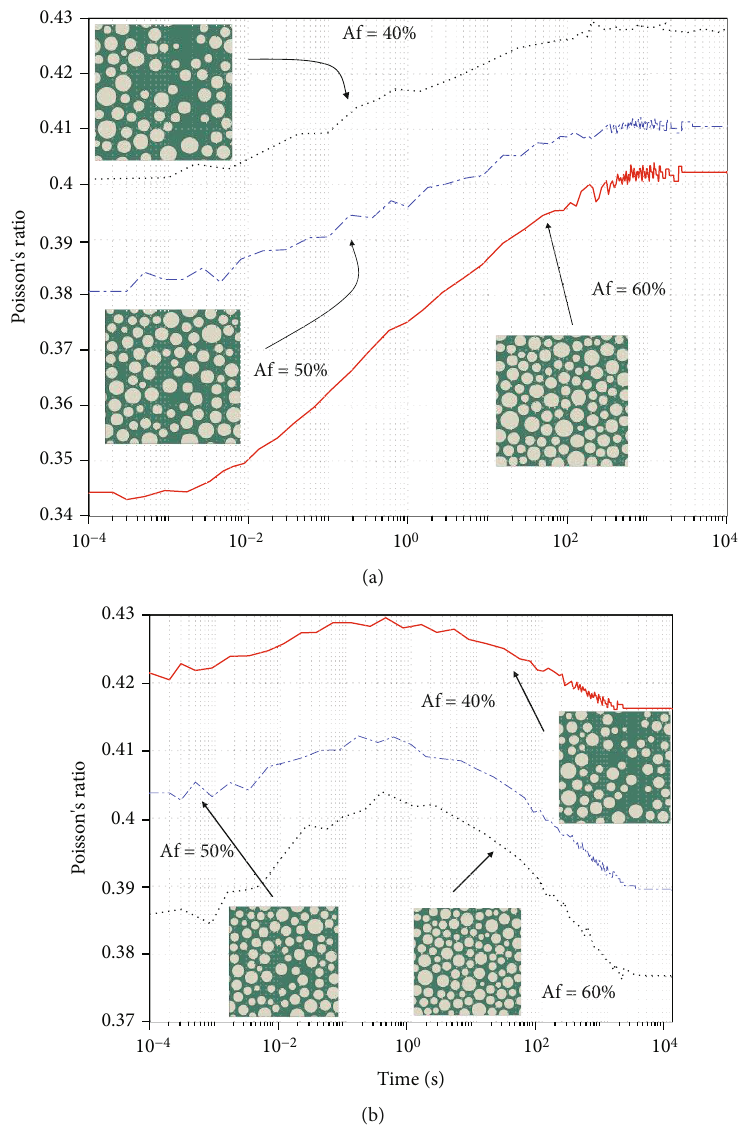
Figure 18: The curves of Poisson ’ s ratio versus time under di ff erent area fractions when cohesive strength equals to (a) 0.2 MPa and (b) 1.0MPa.